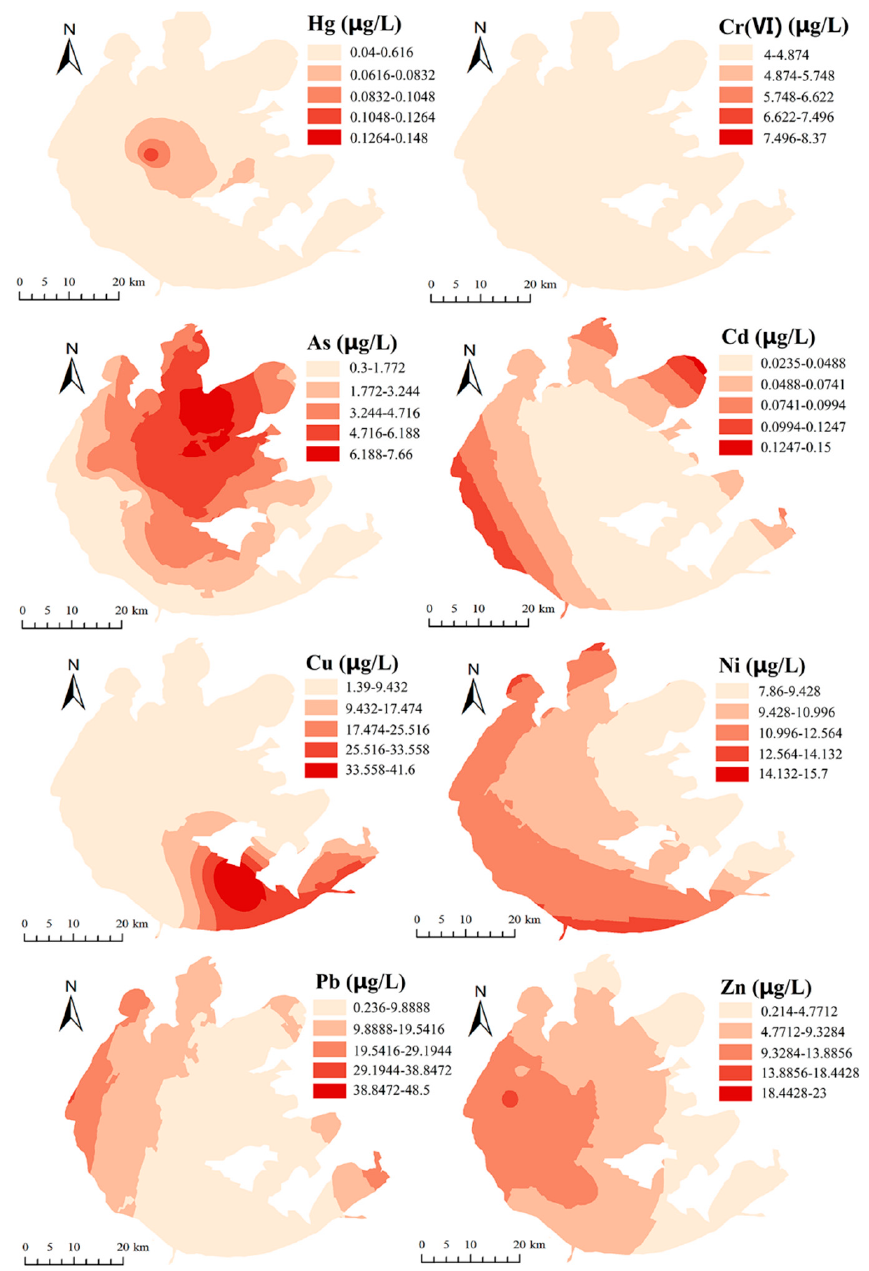
Figure 2. Spatial distributions of eight metals in the surface water of Taihu Lake.